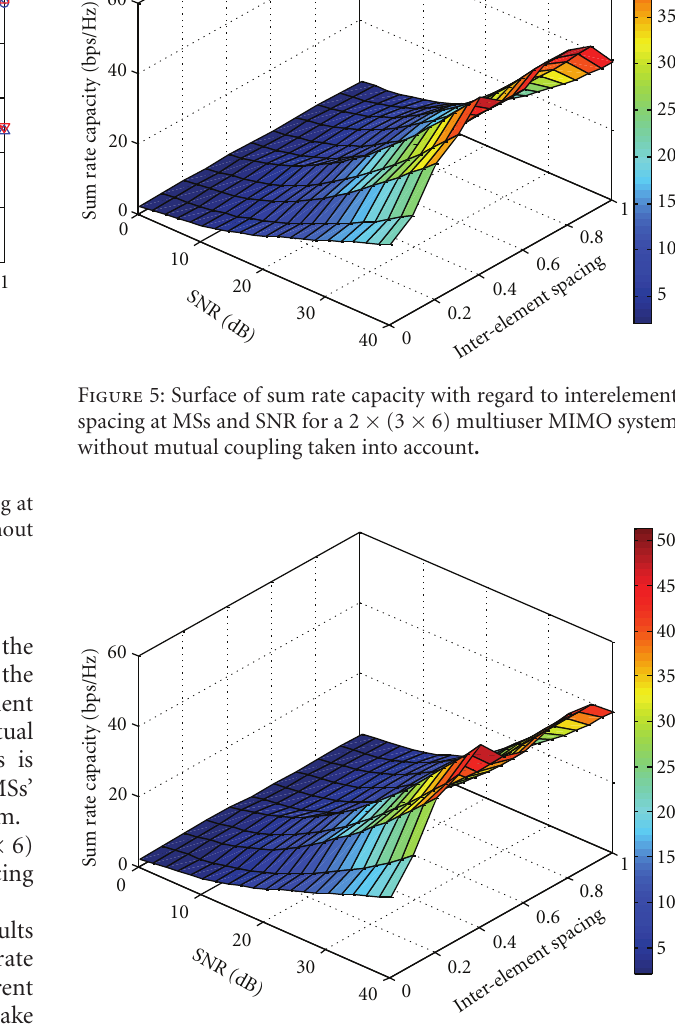
Figure 6: Surface of sum rate capacity with regard to interelement spacing at MSs and SNR for a 2 × (3 × 6) multiuser MIMO system with mutual coupling taken into